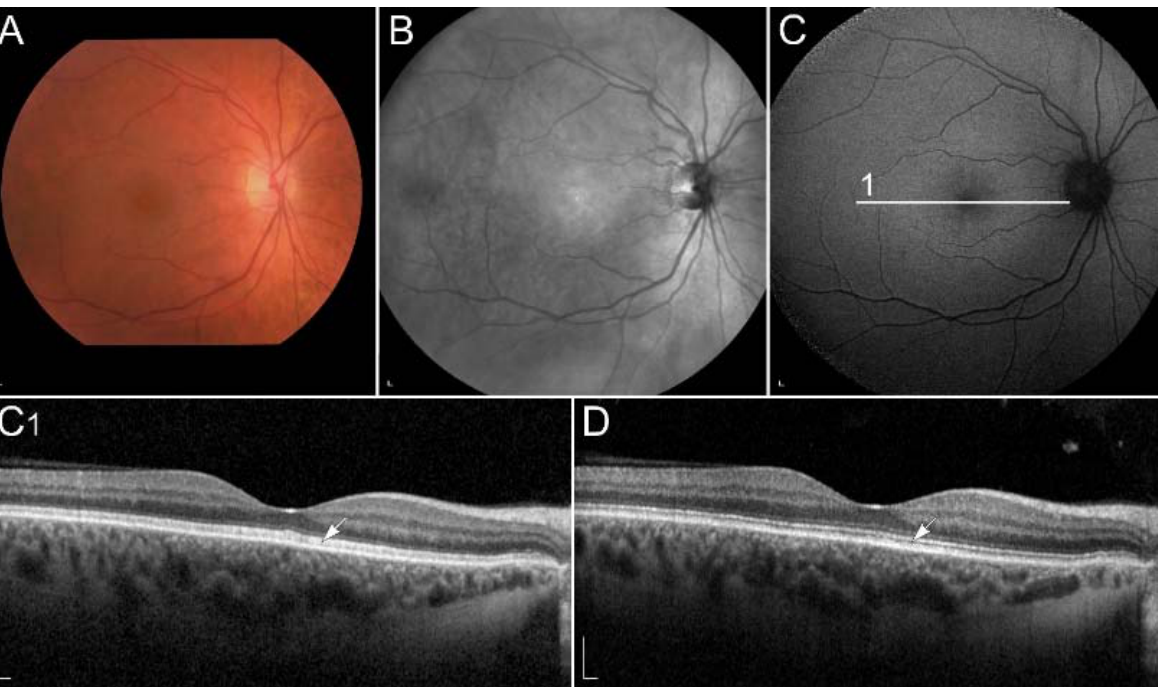
Figure 2. ( A ) Colour fundus image, ( B ) fundus infrared image and ( C ) FAF image in a patient with vitamin A deficiency. Note the corresponding ( C1 , arrow) spectral-domain optical coherence tomography (SD-OCT) image with abnormalities in photoreceptor outer segments, which ( D , arrow) normalized after treatment with vitamin A supplementation. Patient’s best corrected Snellen decimal visual acuity before treatment was 0.7 on the right eye and 0.6 on the left eye. After treatment visual acuity improved to 1.0 on the right eye and 0.9 on the left eye. Scale bars: 200 µ m. Source: Eye Hospital, University Medical Centre